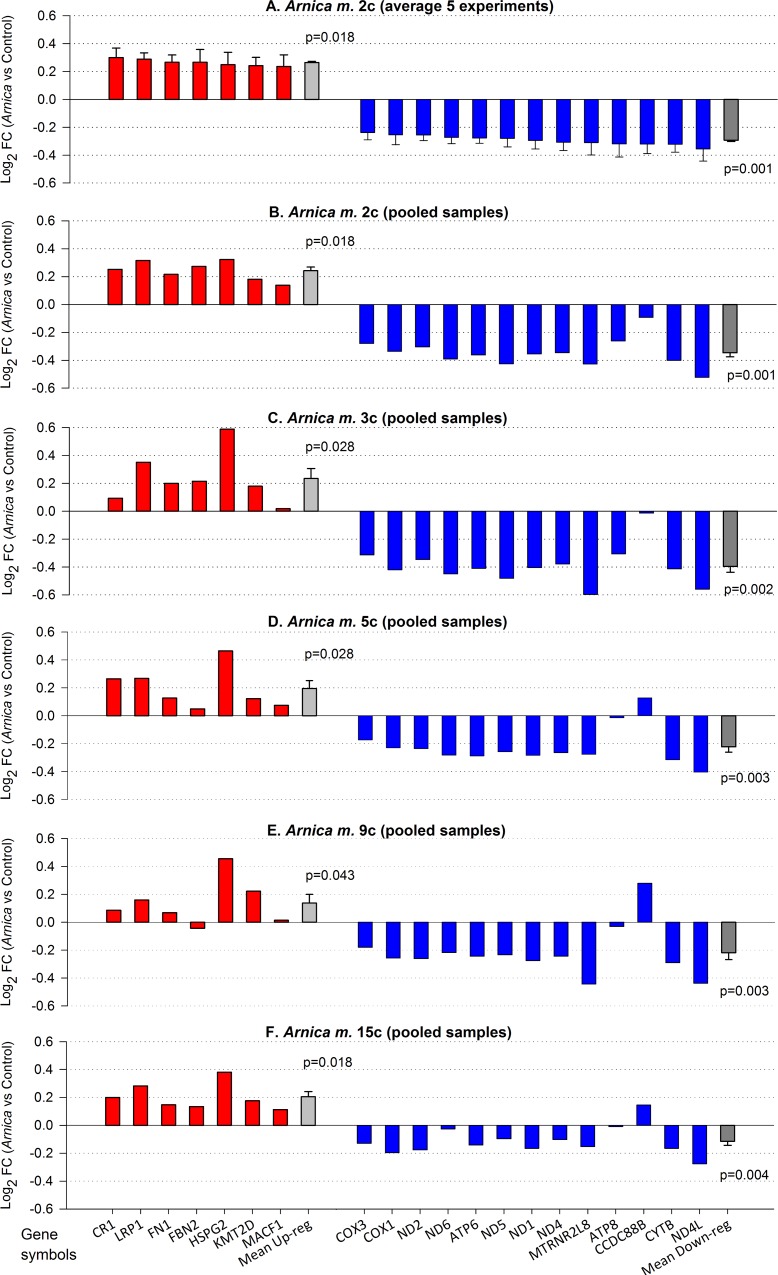
Effects induced by increasing dilutions of Arnica m. on gene expression in THP-1 cells.DEGs described in Table 1 were divided in the two groups as upregulated (red bars) and down-regulated (blue bars) genesets. Grey bars report the mean fold changes ± SE of the two genesets at each dilution tested. Panel A: Arnica m. 2c Log2 fold change values calculated from 5 experiments; Panels B-F Arnica m. 2c, 3c, 5c, 9c, 15c Log2 fold changes values of pooled RNAs of 5 experiments. P values of Wilcoxon signed-rank test statistics are reported near the mean of each geneset.